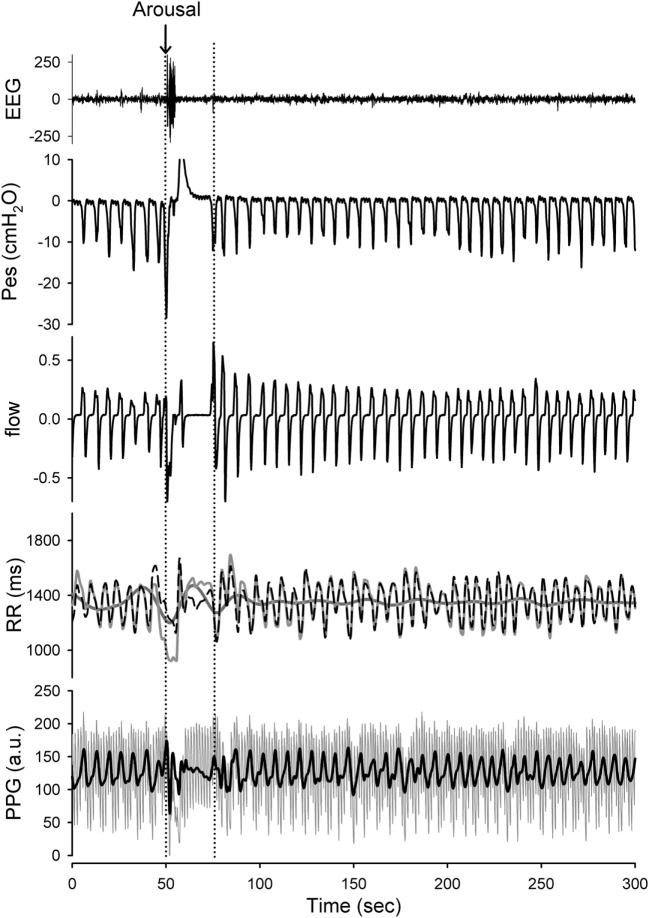
Presentation of the raw data prepared for analysis with Hilbert–Huang transform (HHT). Application of the HHT for reconstructing the instantaneous band-specific fluctuations from RR intervals and photoplethysmography (PPG) signals during stage 2 NREM sleep with increased respiratory efforts. The high-frequency (HF) component (respiratory-related fluctuation; black-dashed line) and low-frequency (LF) component (dark gray line) of the RR interval tracing (light gray line) as well as the respiratory-related component (black) of the PPG signals were determined. A transient arousal was noted in associated with the reversal of high respiratory efforts and return to stage 2 NREM sleep was recorded. The respiratory-related oscillations of the RR intervals and PPG signals can be sifted out with high temporal resolution. The respiratory-related oscillations of the RR intervals and PPG were diminished during arousal-induced central apnea and then returned to higher gain after recovery. In addition, the LF component of the RR intervals was reciprocally increased during arousal.